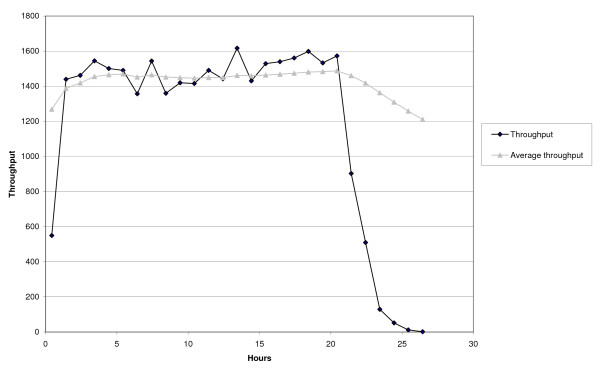
Throughput of Human proteome annotation. Throughput per hour measured both as the number of protein sequences annotated per hourly interval (black) and as the cumulative number of sequences completed divided by the number of hours passed (grey).